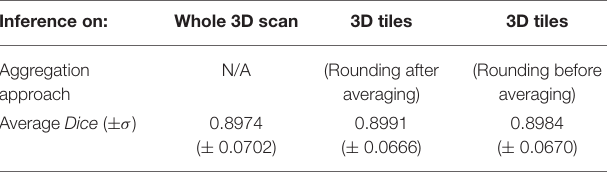
FIGURE 6 | Comparing pairwise Dice differences between the prediction on the whole 240 × 240 image and the 128 × 128 tiles. Zero indicates both methods produced equal Dice scores for the same scan. (Top) Prediction was made by first averaging the 5 tiles and then rounding the final prediction to 0 or 1. (Bottom) Prediction was made by first rounding the tiled predictions to 0 or 1 and then averaging the predictions. TABLE 2 | Results of 3D U-Net on medical data (BraTS).